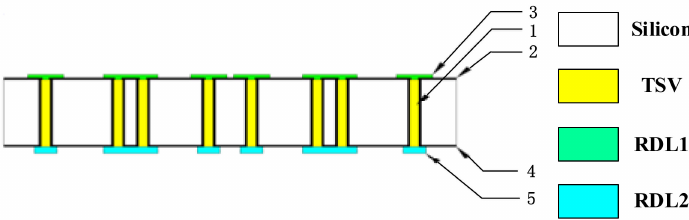
Figure 2. Cross section of the bottom HR-Si interposer wafer.